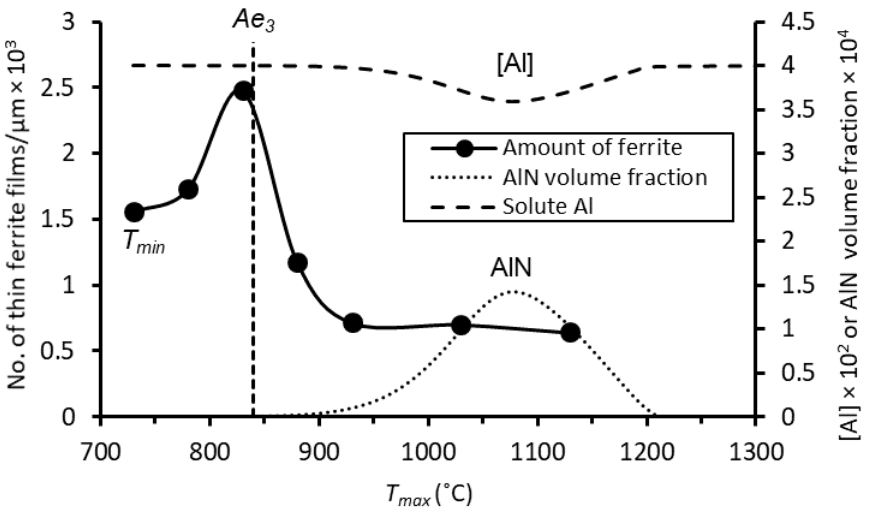
Figure 8. Amount thin ferrite films, predicted AlN volume fraction (TC-PRISMA) and total solute Al as a function of T max from a T min of 730 °C.